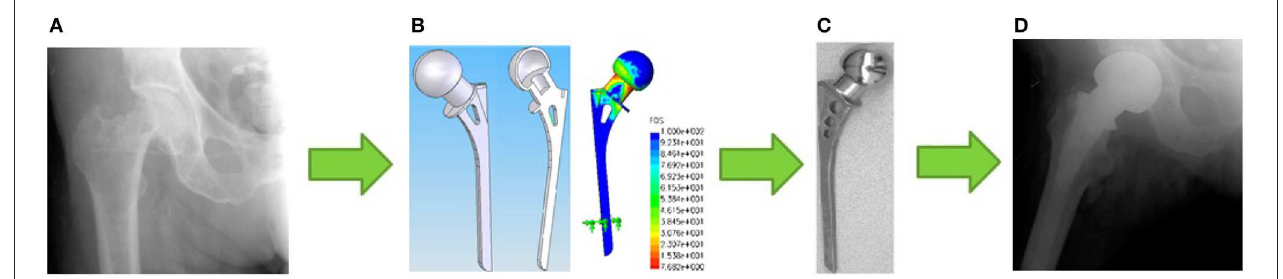
FIGURE 1 | Illustration of the stages of a personalized unipolar hip arthroplasty: (A) the initial stage at which a decision is made on the strategy of surgical intervention; (B) the modeling and development phase of the artificial hip joint personalized design; (C) the manufacturing step of the personalized artificial hip joint; (D) stage of unipolar hip